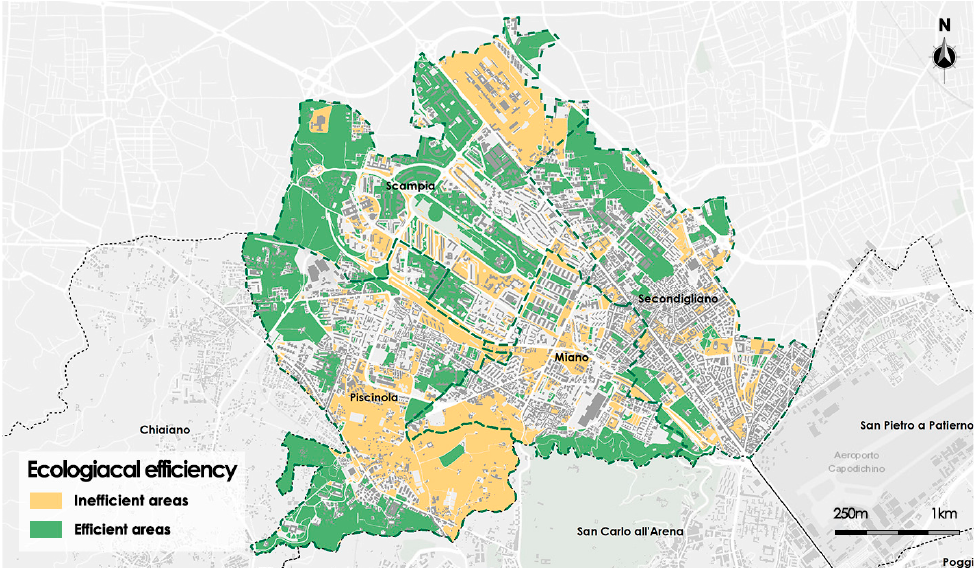
Figure 5. Ex-ante ecological efficiency map of the study area. Table 3. Statistics of districts by ecological efficiency.